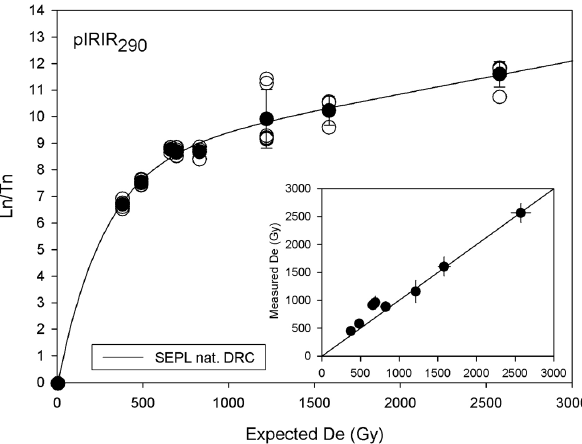
Fig. 8a. Test dose normalised natural optically stimulated lumines- cence signals ( L n / T n ) of the eight samples used for the pIRIR 290 protocol plotted against their expected equivalent dose values ( D e ) (Chapot et al., 2012). The expected D e for each sample was calcu- lated by multiplying the environmental dose rate by the expected age. The inset shows the comparably good agreement between the expected and the measured D e . The solid line is the 1:1 line.